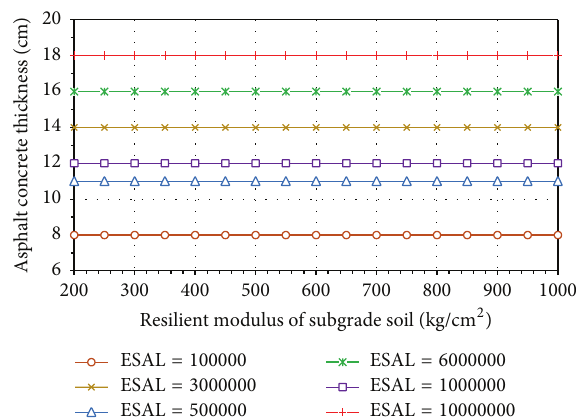
Figure 8: Optimal design thickness of asphalt concrete for express- ways and freeways.